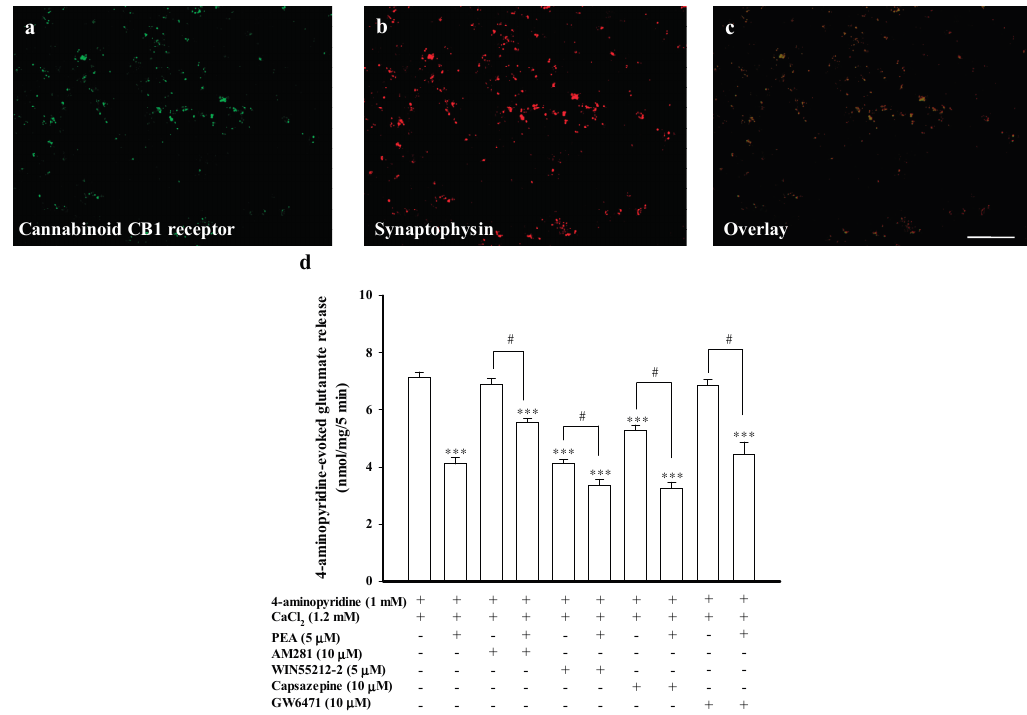
Figure 6. PEA-mediated inhibition of evoked glutamate release is partially blocked by the selective cannabinoid CB1 receptor antagonist AM281. Synaptosomes were fixed onto polylysine-coated coverslips and double stained for immunocytochemistry with antisera against cannabinoid CB1 receptors (red in ( a )) and the vesicular marker synaptophysin (green in ( b )). Merged panels are shown in ( c ) (orange). Scale bar, 10 μ m; ( d ) Bar graph showing glutamate release induced by 1 mM 4-aminopyridine in the absence (control) or presence of 5 μ M PEA, 10 μ M AM281 (an antagonist of cannabinoid CB1 receptor), 10 μ M AM281 and 5 μ M PEA; 5 μ M WIN55212-2 (an agonist of cannabinoid CB1 receptor), 5 μ M WIN55212-2 and 5 μ M PEA; 10 μ M capsazepine (an antagonist of TRPV1); 10 μ M capsazepine and 5 μ M PEA; 10 μ M GW6471 (an antagonist of PPAR α ); or 10 μ M GW6471 and 5 μ M PEA. Results are mean ± SEM of 5–7 independent experiments. *** p < 0.001 versus control group. # p < 0.05 versus the AM281-treated